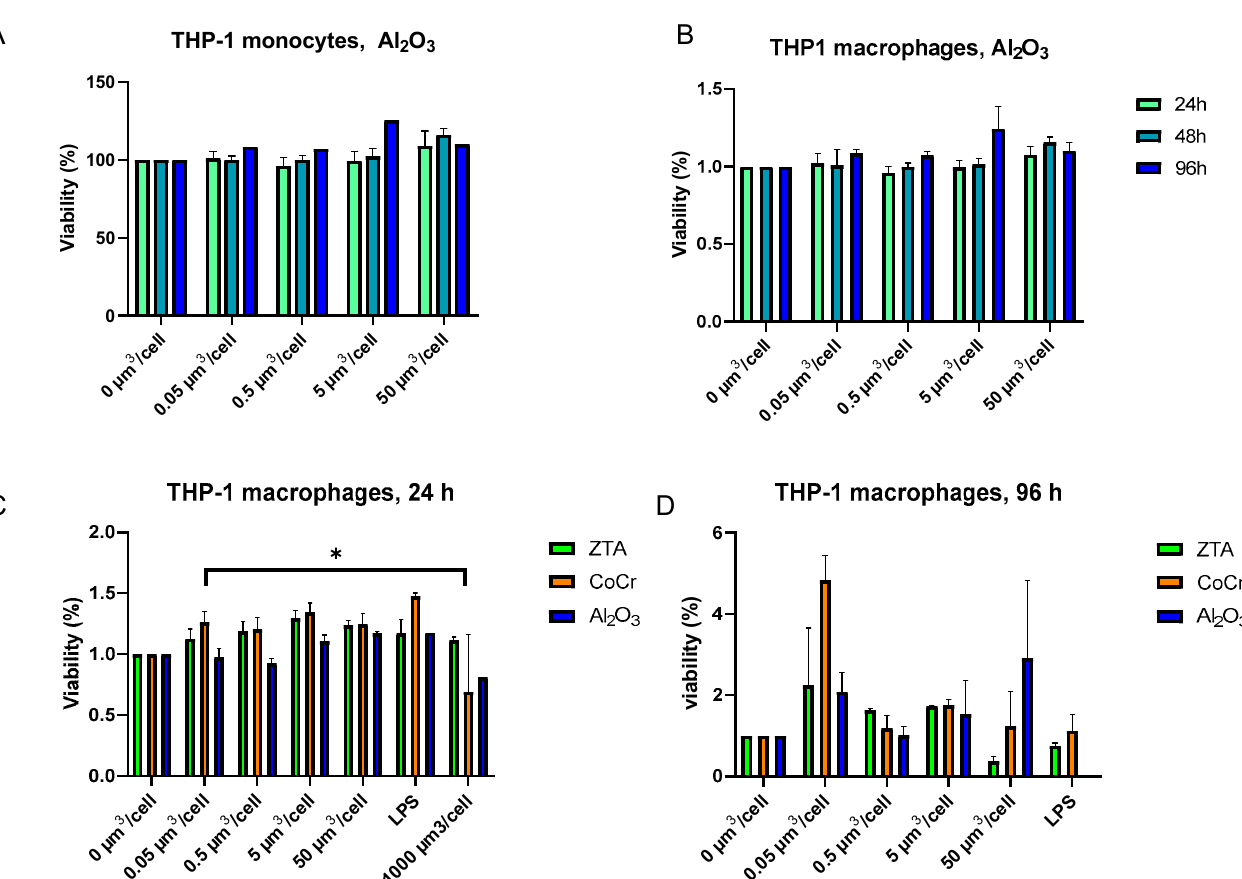
Figure 1. Al 2 O 3 and ZTA particles do not affect THP-1 macrophage viability. Cell viability was measured by MTS assay. THP-1 monocytes ( A ) and THP-1 macrophages ( B ) were treated with Al 2 O 3 particles for 24, 48, and 96 h ( A ). THP-1 macrophages were treated with ZTA, CoCr, or Al 2 O 3 particles for 24 h ( C ) and 96 h ( D ). The results are represented as relative values in which untreated cells represent 100% viability. At least three biological repeats are depicted. The results are expressed as the mean ± SEM. *— p < 0.05.